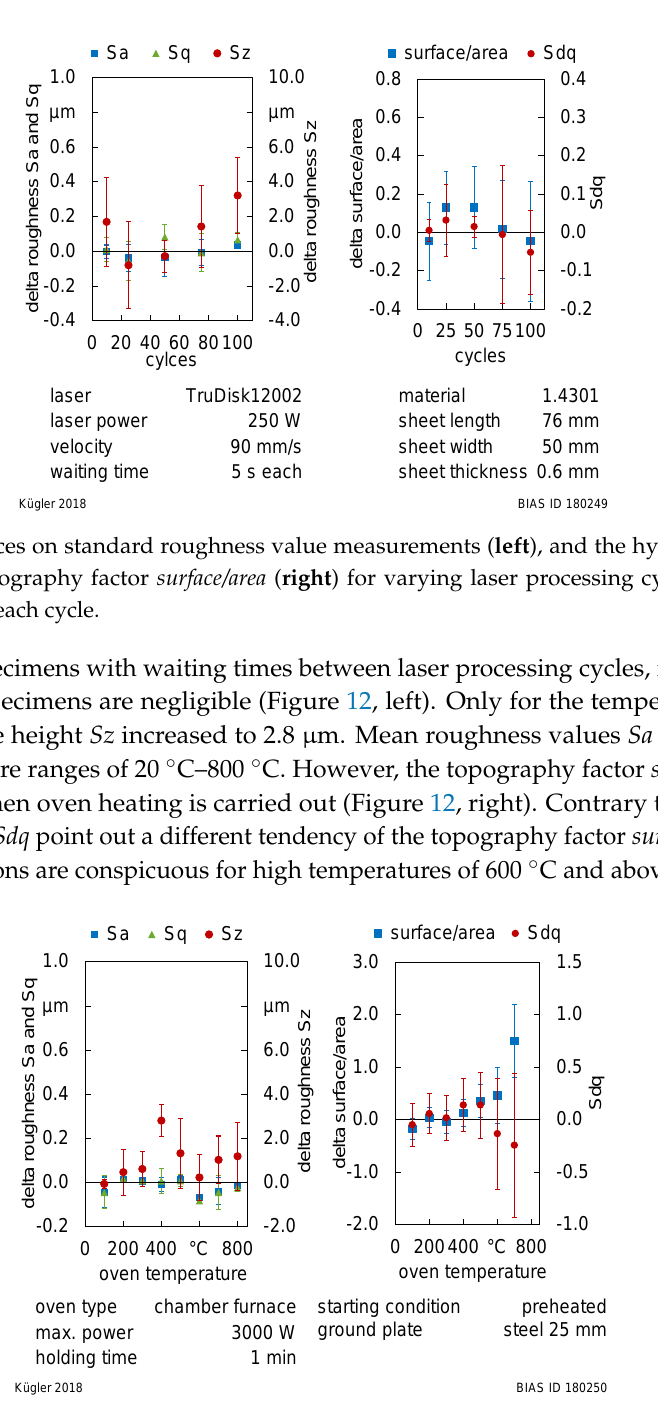
Figure 13. The absorption values influenced by multiple laser processing with a 5 s waiting time ( left ) and oven heating ( right ). 5. Discussion The results clearly show that the absorptivity of a stainless steel sheet surface is not constant when heating without shielding gas is applied. Variations of absorption values were produced by using a laser beam as well as an oven. However, a clear dependence of heating treatments on a certain roughness value cannot be determined. Sz seems to be more inconsistent and therefore makes clear